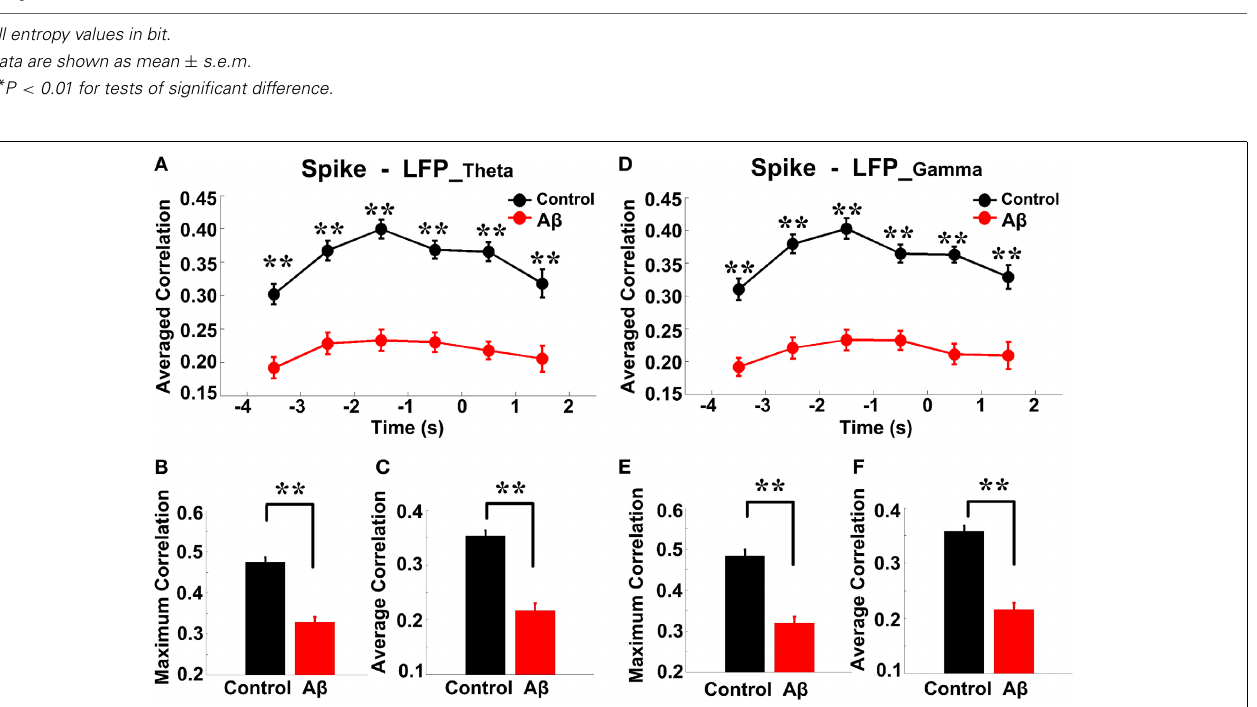
error bars reflect one standard error of the mean. (B) Peaks of spike-LFP theta correlation ( ∗∗ P < 0 . 01). (C) Average spike- LFP theta correlation. (D) Averaged entropy correlations between spikes and gamma band LFPs. (E) Peaks of spike-LFP gamma correlation. (F) Averages of spike-LFP gamma correlation.